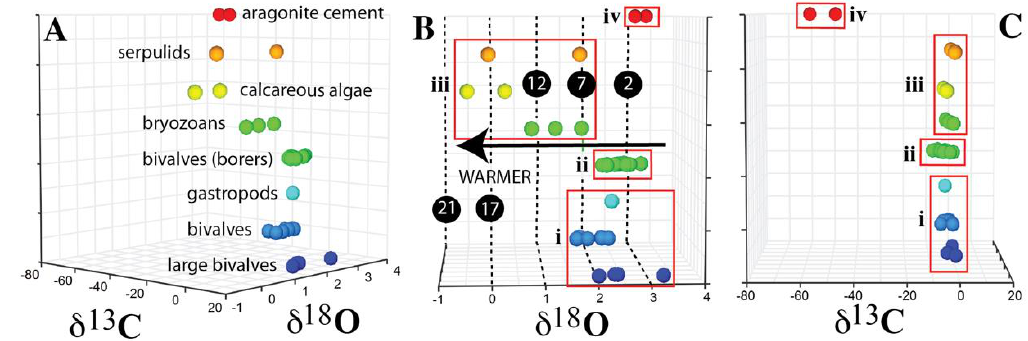
Figure 5. Plots of δ 18 O and δ 13 C values, for materials measured during the current study. ( A ) Three-dimensional plot of δ 13 C versus δ 18 O, divided into individual specimen types along the z -axis, ( B ) as in ( A ) rotated to clearly display di ff erences in δ 18 O between groups, ( C ) as in ( B ) but to show δ 13 C. Key: (i) pre-hardground fauna (bivalves and gastropods); (ii) post-hardground “boring” bivalve fauna, or co-occuring bivalve fauna associated with hardground cementation; (iii) late developing encrusters (bryozoan, encrusting calcareous algae, serpulid tubes); (iv) aragonite needle-like cement. Figures in black circles = T ◦ C after Epstein et al. [17]. Note vertical axis only used to separate the di ff erent tested groups, no scale. Temperature values for aragonite cement are not likely to be accurate (see Section 4.2.1).